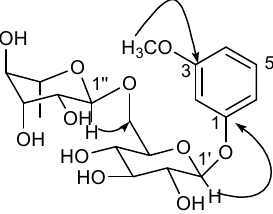
Figure 2. Key HMBC correlations of compound 1